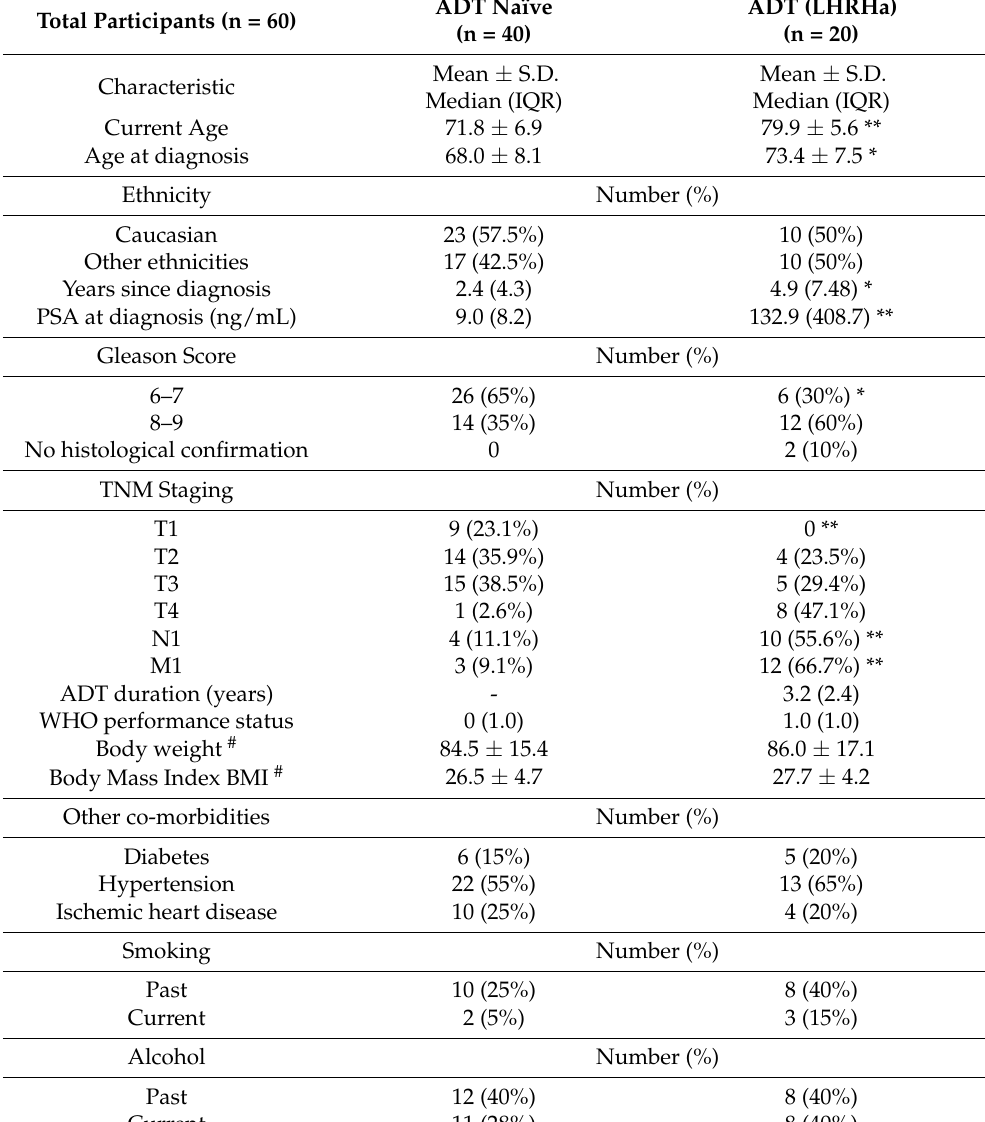
Table 1. Demographic and clinical characteristics of participants who were ADT naïve or on ADT with an LHRHa drug. Data are presented as either mean ± standard deviation or median (interquartile range), depending on data